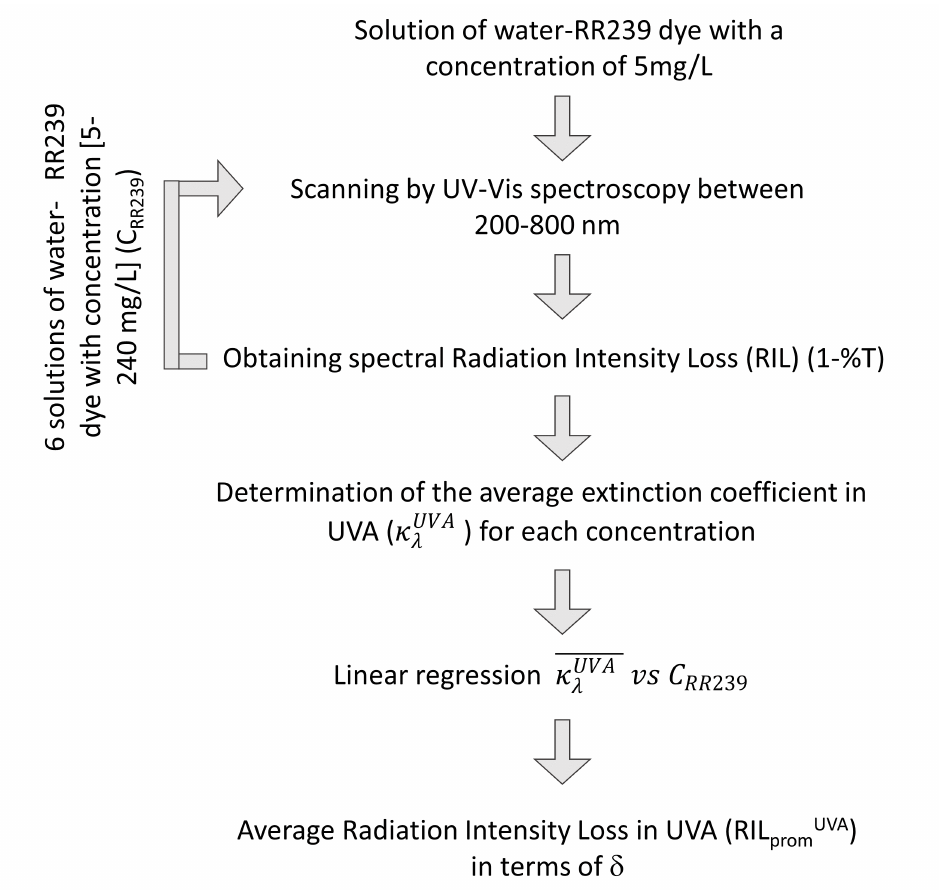
Figure 5. Procedure followed for determining the RIL as a function of δ